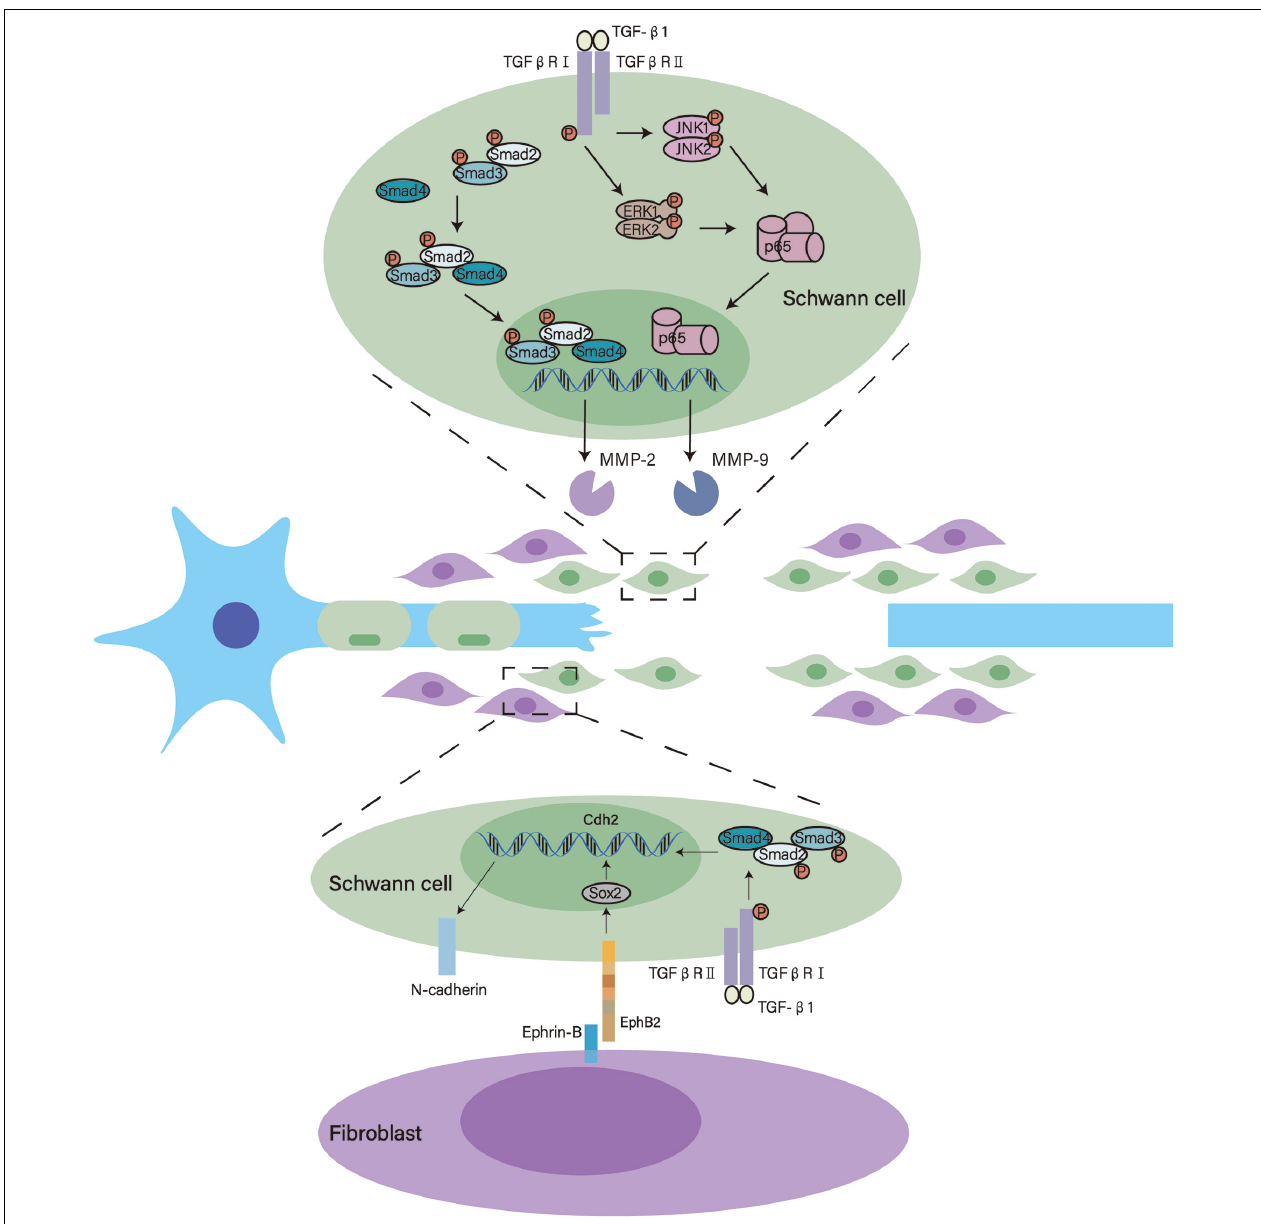
FIGURE 2 | Underlying mechanisms of TGF- β in the formation of bands of Büngner. TGF- β activates Smad2/3 and enhances MMP-2 transcription. Meanwhile, TGF- β activates ERK1/2 and JNK1/2 that modulate p65/NF- κ B, thus promoting MMP-9 transcription. These signaling pathways facilitate SC migration and